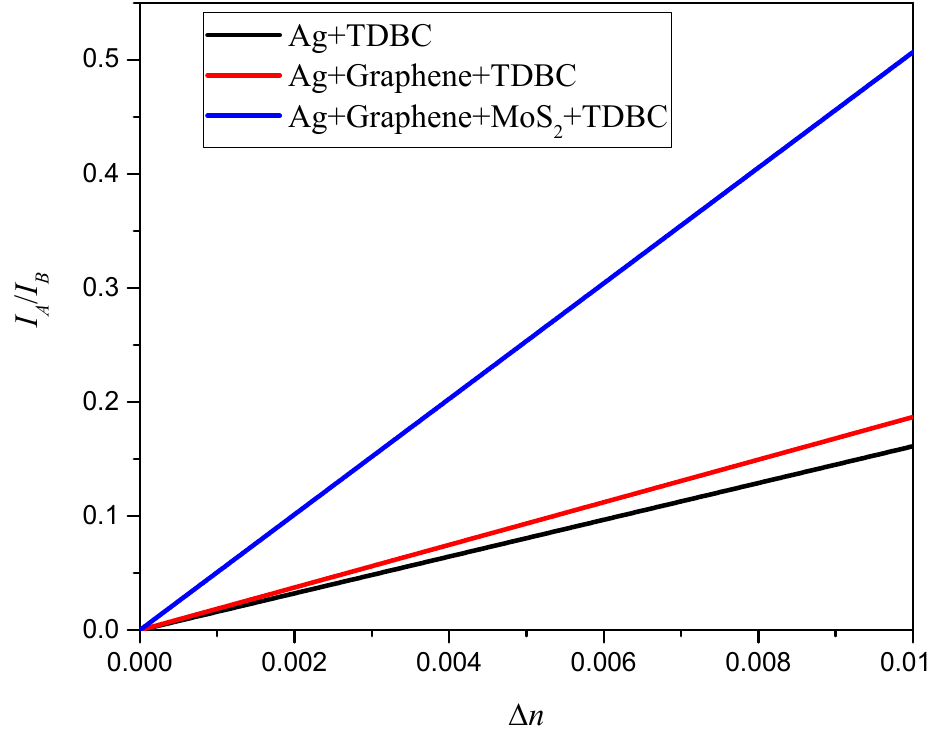
Figure 8. Sensing performance of three SPR sensing platforms: 43 nm thick Ag film ( black ), Ag film coated with single ‐ layer graphene ( red ), and Ag film coated with single ‐ layer graphene and three layers of MoS 2 ( blue ).